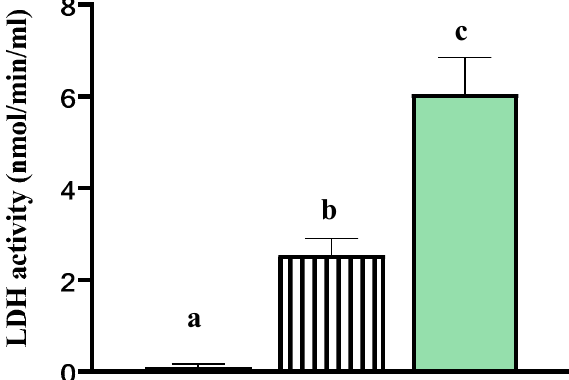
Figure 2. Lactate dehydrogenase (LDH) activity (mmol/min/mL) from basal media alone ( ), tissue explants cultured in media ( ), and tissue explants incubated in Triton X-100 ( ). Data are presented as least square means ± standard error of the mean (SEM) Different letters a–c indicate p- value < 0.05. LDH activity was higher in the media of explants incubated in Triton X-100 at room temperature relative to both the media from tissue explants cultured in vitro and relative to the basal media deprived of tissue explants. This indicated that cells within the explants cultured in vitro for 24 h were viable.